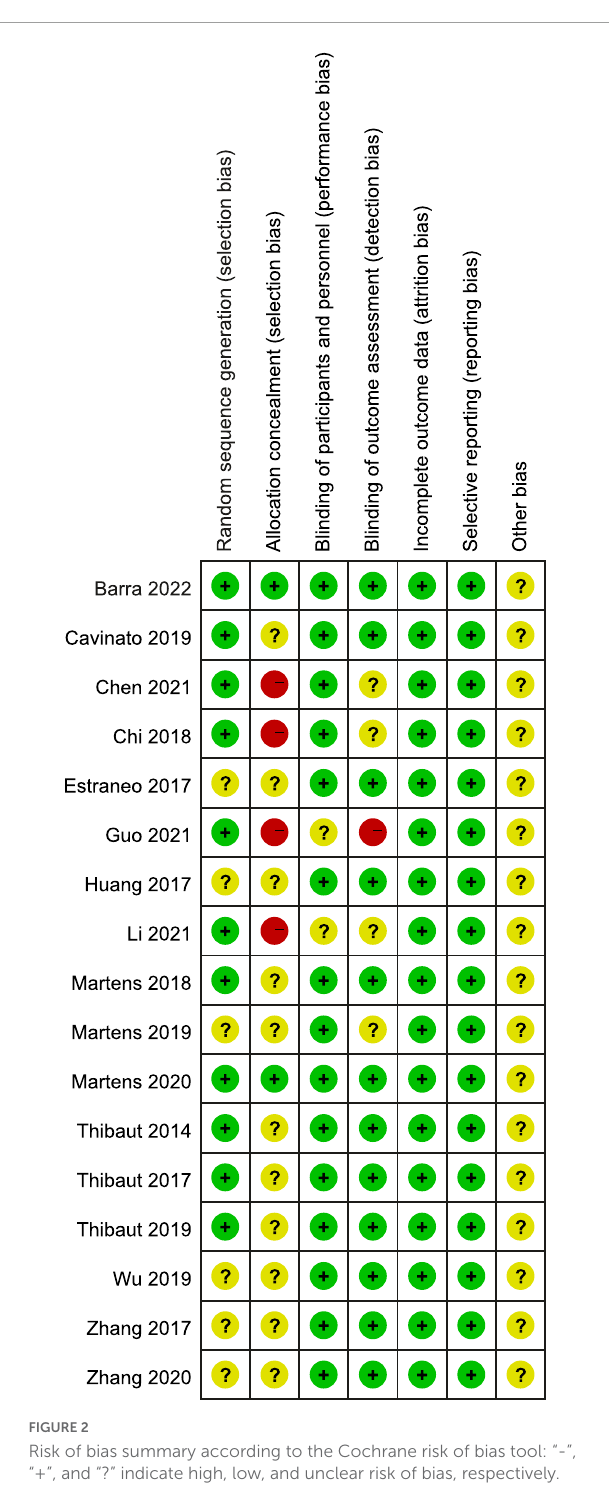
or VS ( MD = − 0.06; 95% CI = − 0.56 to 0.43; P = 0.80; Figure 8